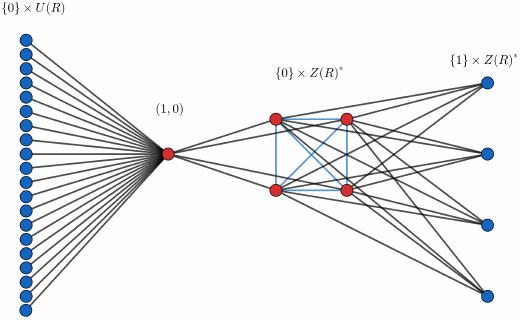
Figure 2. Diagram of the graph Γ ( Z 2 × Z 25